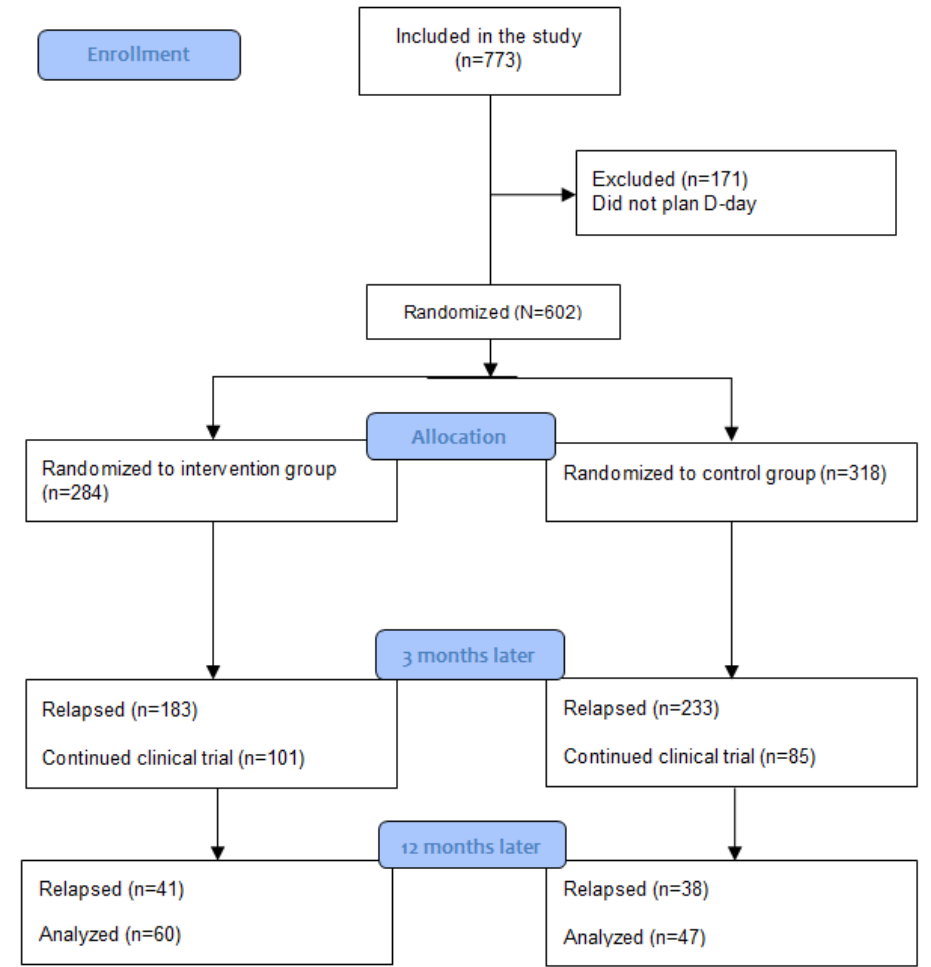
Figure 1. Flowchart of the participants included in the